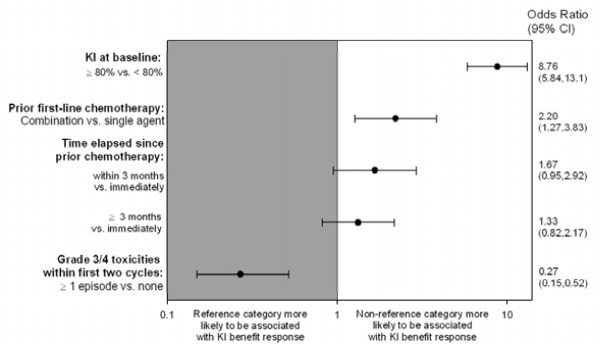
Odds ratios for patients' characteristics potentially associated with KI benefit response after the second treatment cycle. CI = confidence interval, KI = Karnofsky Index. Odds ratios derived from univariate regression analyses, including all eligible patients (N = 521). Reference categories: KI at baseline = < 80%, prior first-line chemotherapy = single agent, time elapsed since prior chemotherapy = immediately, Grade 3/4 toxicities = none. Time elapsed since prior chemotherapy: Immediately = first dose of pemetrexed given ≤ 28 days after the last dose of first-line therapy. Within 3 months = first dose of pemetrexed given > 28 days but ≤ 3 months after the last dose of first-line therapy. Later than 3 months: first dose of pemetrexed given > 3 months after the last dose of first-line therapy